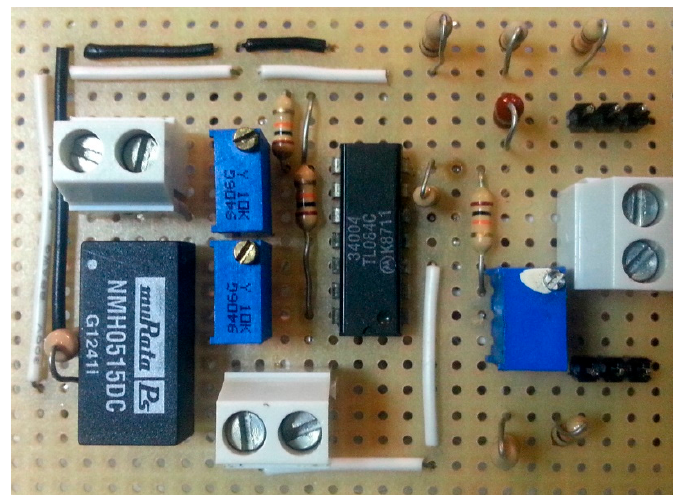
Figure 6. Prototype of the MCLAL circuit of Figure 5.